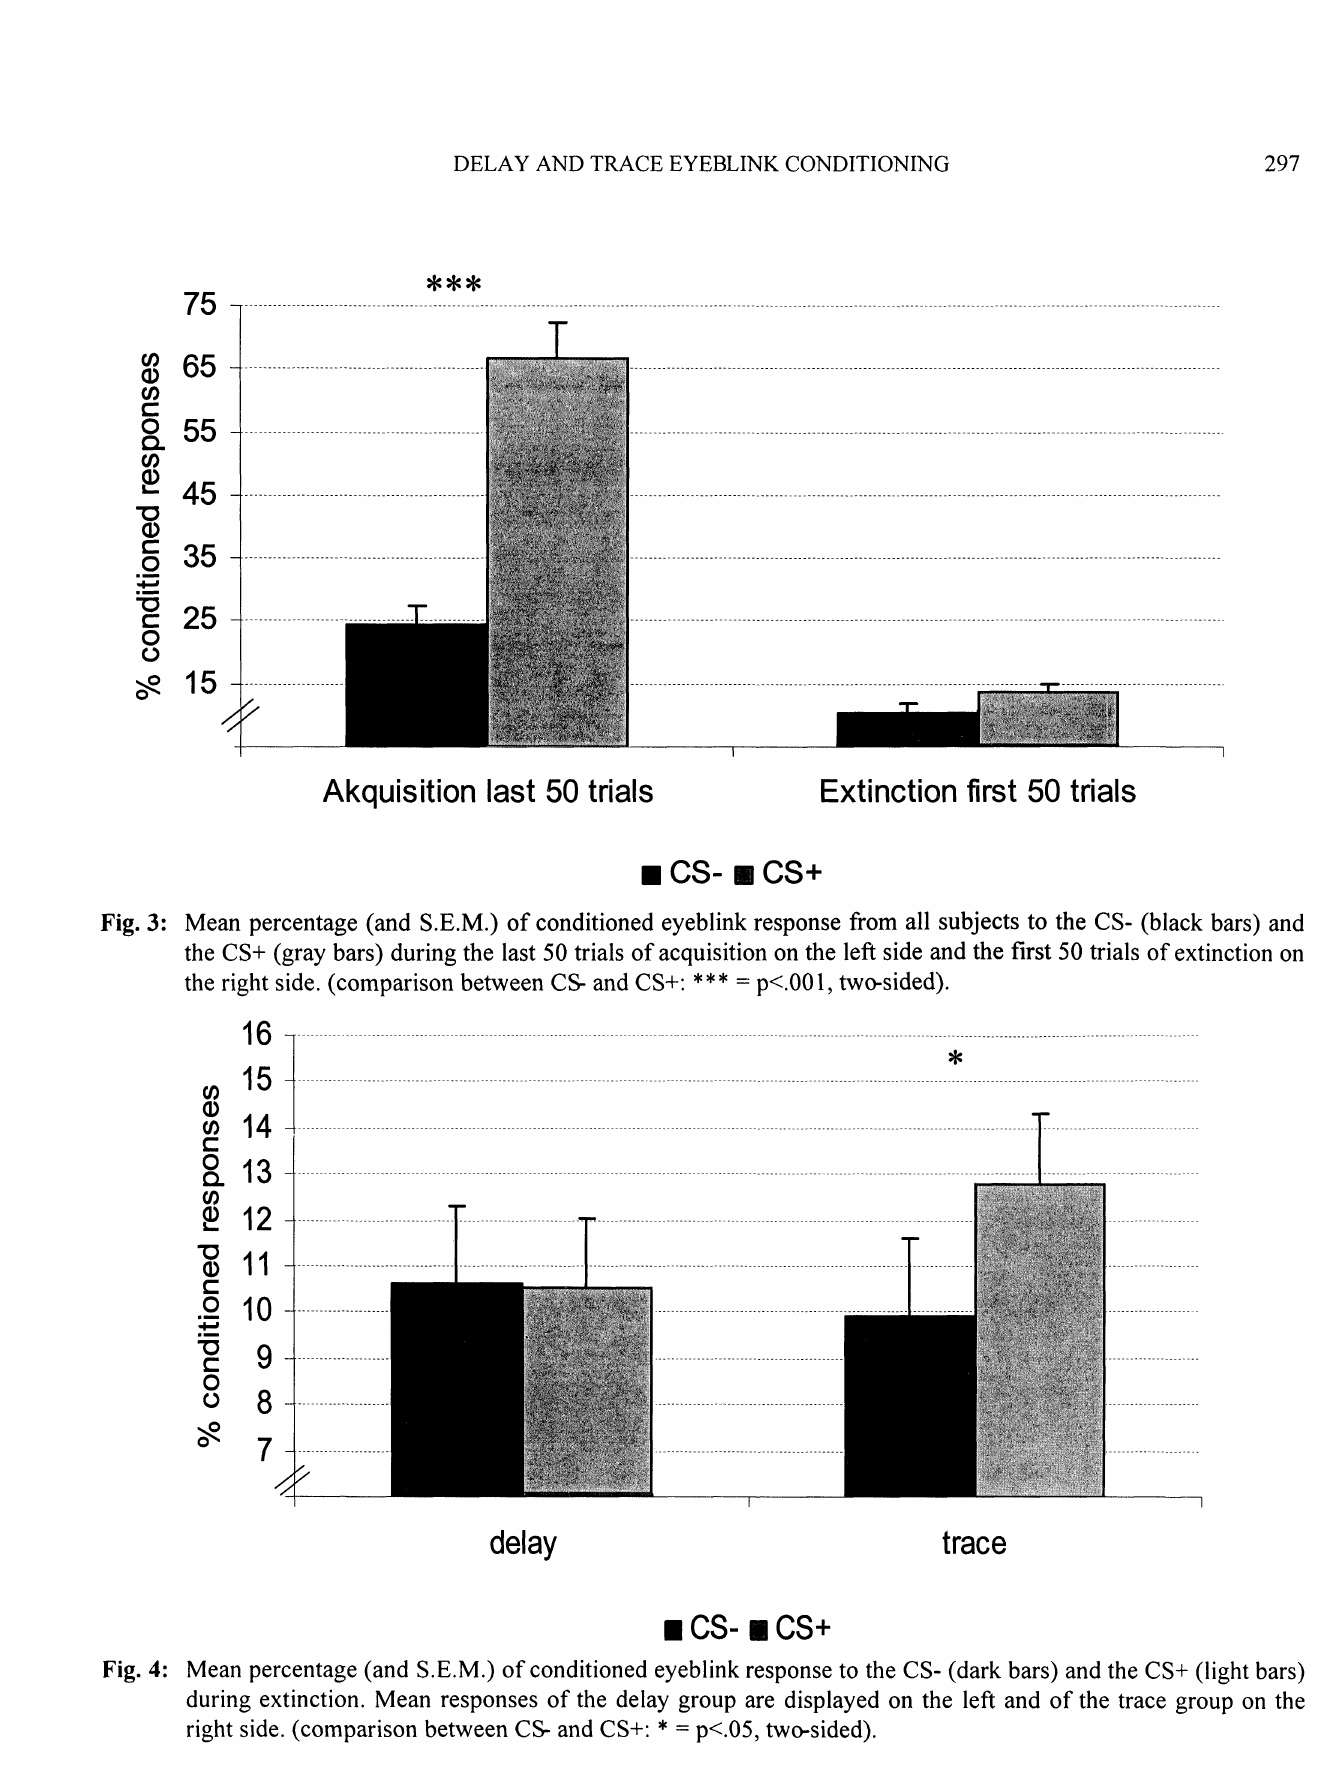
Fig. 4" Mean percentage (and S.E.M.) of" conditioned eyeblink response to the CS- (dark bars) and the CS+ (light bars) during extinction. Mean responses of the delay group are displayed on the left and of the trace group on the right side. (comparison between CS- and CS+’ * p<.05,